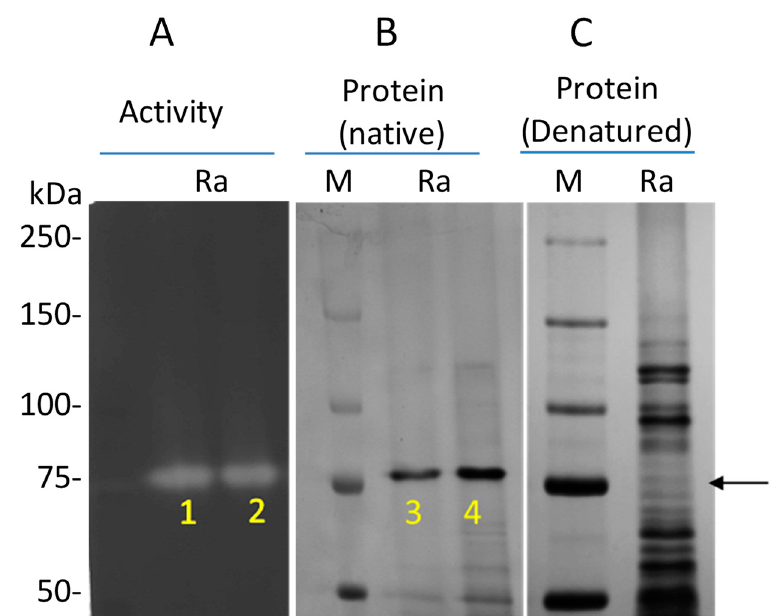
Figure 4. Identification of the gluten degrading enzyme from R. aeria . ( A ) Gel part developed as a zymogram gel using externally added casein as the enzyme substrate to visualize bands with enzyme activity (indicated with an arrow). ( B ) Native PAGE gel part stained with Coomassie brilliant blue. ( C ) SDS-PAGE mini gel stained with Coomassie brilliant blue. Bands 1–4 were excised and subjected to mass spectrometric analysis.